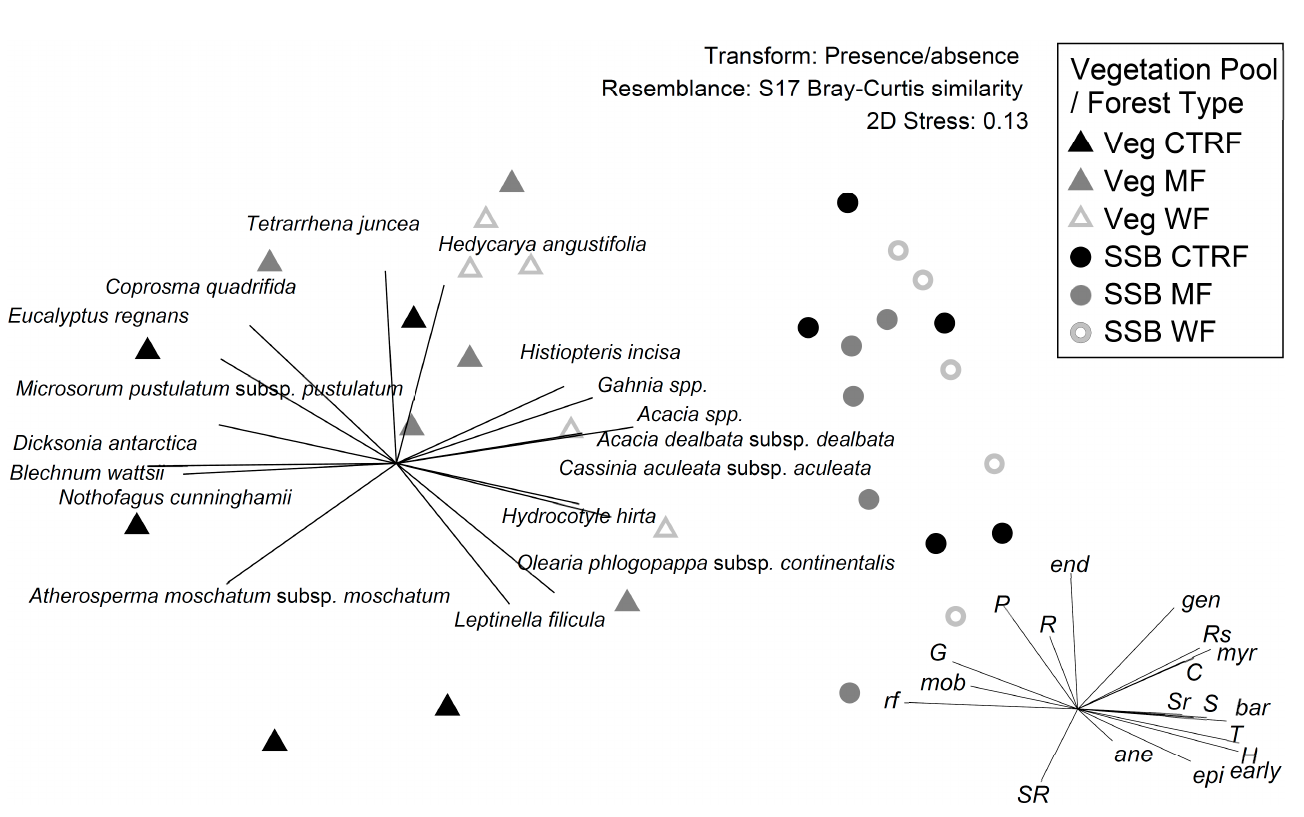
Figure 4. NMDS ordination of presence–absence data for species in the germinable soil seed bank (SSB) and extant vegetation (Veg) across three forest types (CTRF, cool temperate rainforest; MF, mixed forest; WF, wet forest) in the Central Highlands of south-eastern Australia. Symbols represent individual sites and are coded according to vegetation pool (shape) and forest type (colour). The vector overlay represents the strength and direction of the relationship for underlying species with r ≥ 0.65. The vector insert (bottom right) represents relationships with all underlying plant functional types. Life form: C, chamaephyte; G, geophyte; H, hemicryptophyte; P, phanerophyte; T, therophyte. Dispersal mode: ane, anemochory; bar, barochory; end, endozoochory; epi, epizoochory; mob, mobile; myr, myrmecochory. Fire response: R, obligate resprouters; S, obligate seeders; SR, facultative seeders; Sr, weak seeders; Rs, weak resprouters. Seral stage: gen, generalist; rf, Table 3. Mean number of species per site (across all forest types) with each a tt ribute in the soil seed bank and extant vegetation and the mean contribution to dissimilarity between vegetation pools as determined by SIMPER tests (following PERMANOVA, Pseudo-F and p values shown). A tt ributes are ordered according to their contribution to dissimilarity.